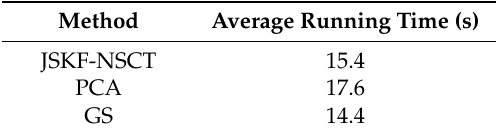
Table 16. Test and comparison of computationally